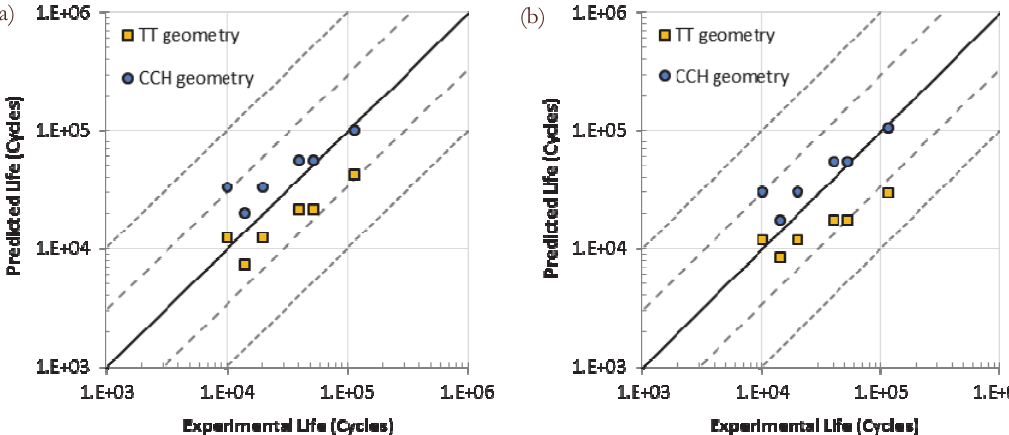
Figure 2: Constant amplitude crack growth life predictions based on (a) FASTRAN and (b) UniGrow